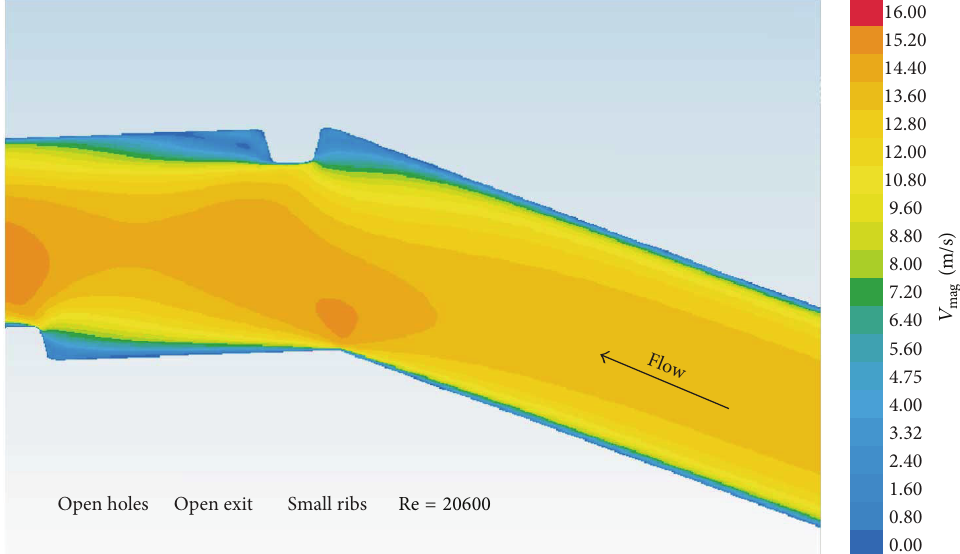
Figure 12: Velocity magnitude contours around the channel tilt for the case of open trailing-edge holes and open exit with small ribs.